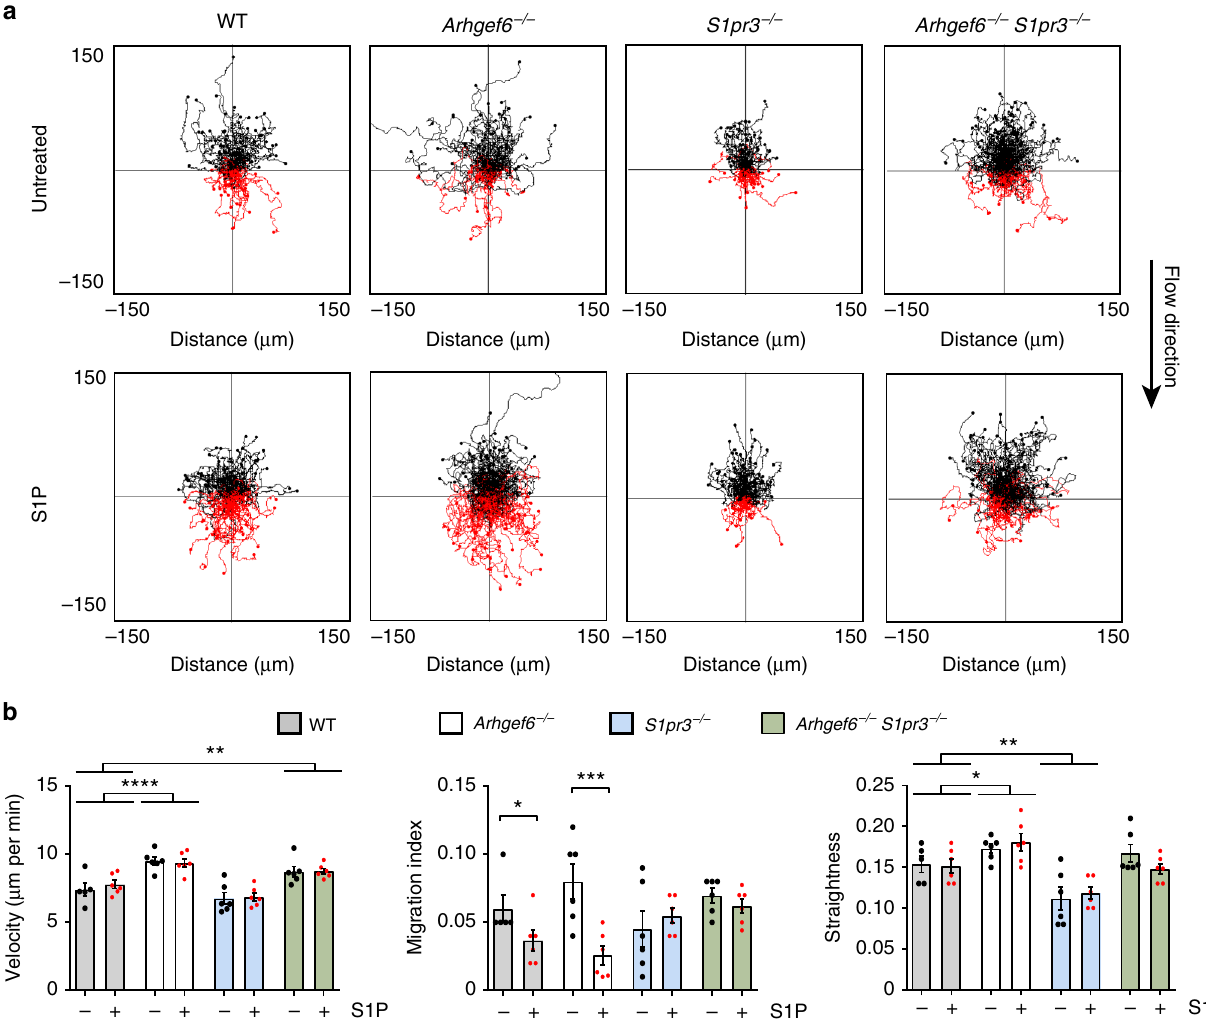
Fig. 7 S1P inhibition of MZB migration up the fl ow requires S1PR3. a Representative track plots of wild-type (WT), Arhgef6 − / − , S1pr3 − / − , and Arhgef6 − / − S1pr3 − / − MZB, untreated or treated with S1P (200 nM), migrating under fl ow (3 dyn cm − 2 ) on ICAM-1 (2.5 µ g ml − 1 ). b Quanti fi cation of velocity, migration index, and straightness. Two-way ANOVA signi fi cance indicated with horizontal bars for genotype signi fi cance, brackets for Mann – Whitney test (migration index). Bars show mean ± SEM. * P < 0.05, ** P < 0.01, *** P < 0.001, **** P < 0.0001. Data represent 12 experiments with two mice each, six mice per genotype total. Symbols in one condition group denote the replicates and represent the average of 100 – 200 cells from each individual